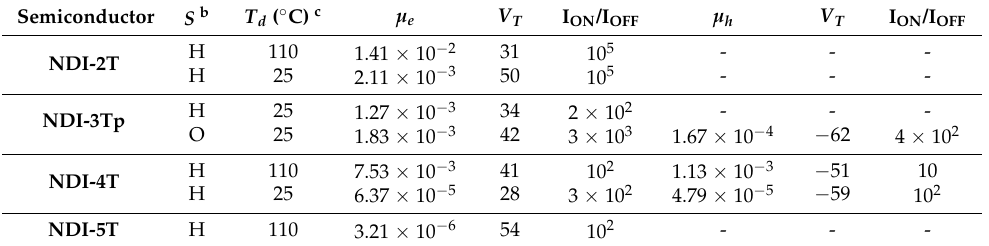
Table 3. OFET electrical data for vapor-deposited films of NDI-2T , NDI-3Tp , NDI-4T and NDI-5T measured under vacuum on Si/SiO 2 substrates. Average field-effect mobilities are shown a . Semiconductor S